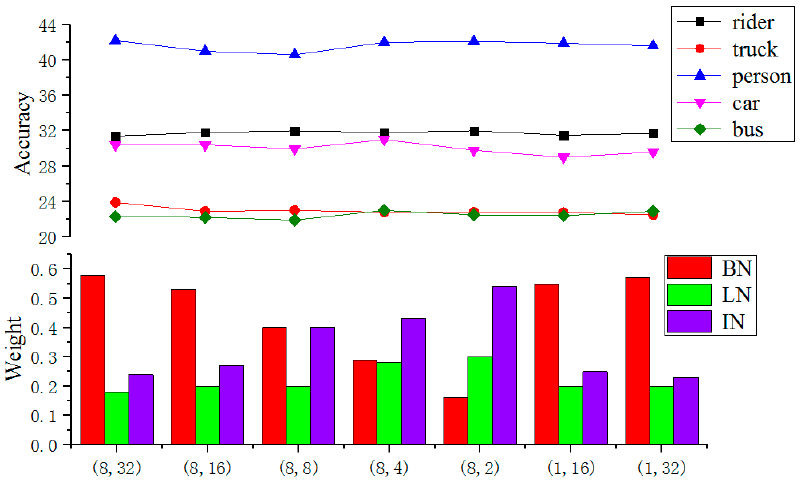
Figure 3. Improved segmentation accuracy regardless of the target under SN weight